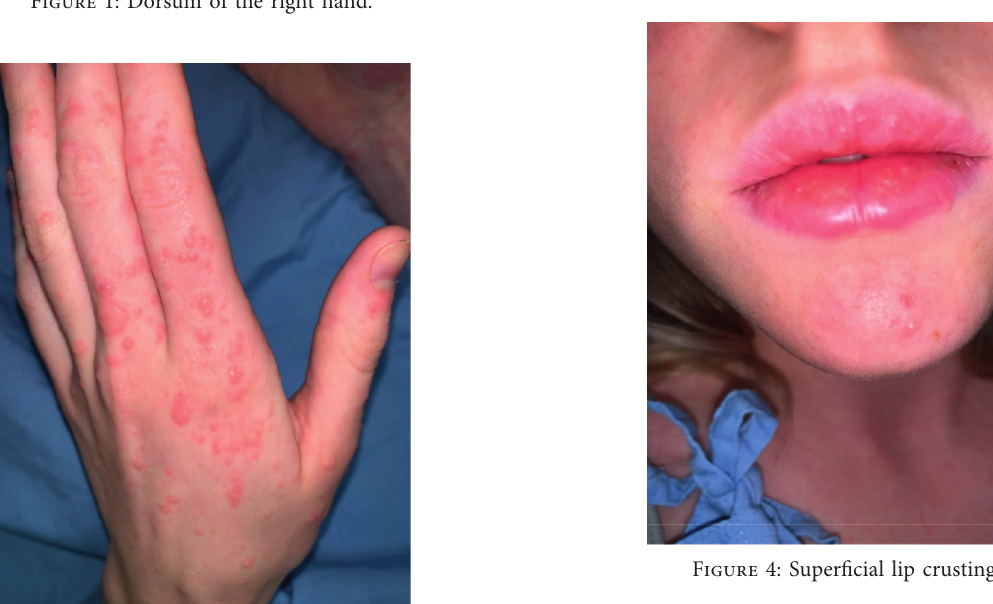
Figure 1: Dorsum of the right hand.